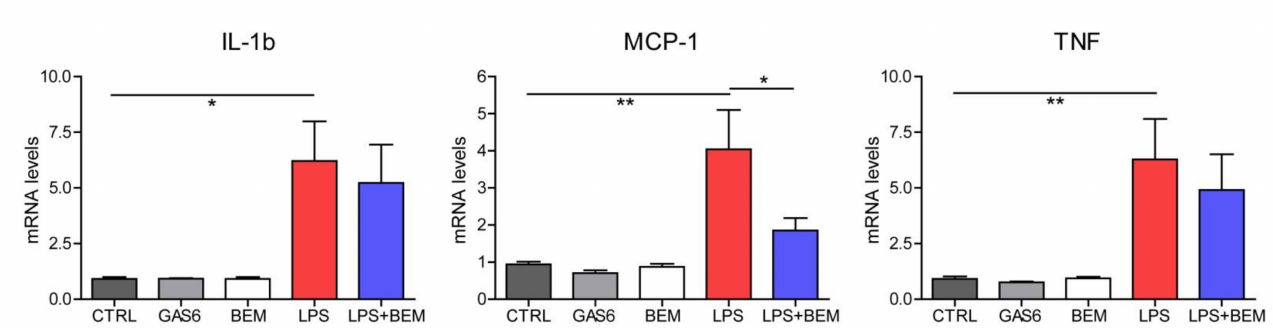
Figure 5. AXL inhibition reduced cytokine production upon LPS challenge in activated human macrophages (THP-1 cells). Phorbol 12-myristate 13-acetate (PMA)-activated THP-1 cells were exposed to LPS (50 ng/mL) and/or pre-incubated for 1 h with bemcentinib (1 µ g/mL). mRNA levels of IL-1 β , MCP-1, and TNF were determined 2 h later. A control group was stimulated with recombinant human 500 ng/mL GAS6. Groups were compared using one-way Anova. *, p < 0.05; **, p <